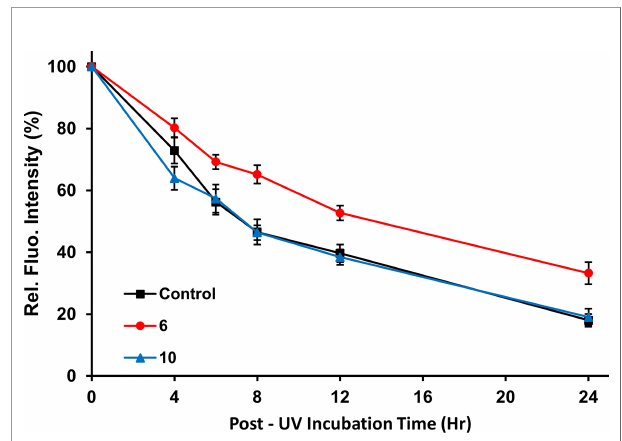
FIGURE 4 | Inhibition of cellular NER. Immuno fl uorescence images were obtained at various time points to monitor the removal of CPDs from UVC- irradiated HCT-116 cells treated with vehicle only (control), compound 10 (2 m M; negative control), or compound 6 (2 m M). Plot shows the normalized fl uorescence intensity of the cells based on quantitation of fl uorescence from 100 cells randomly selected per time point. Error bars indicate the S.E.M. The measured intensities of cells treated with the active inhibitor, compound 6 were signi fi cantly different from the non-inhibitory negative control, compound 10, at time points from 4 to 24 h post-irradiation (p < 0.005, Student ’ s t-test) indicating that compound 6 slows the removal of CPD.